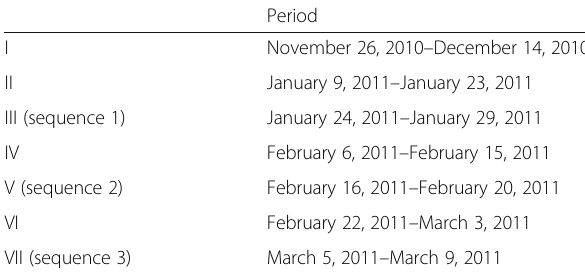
Table 2 Periods used for calculation of variations in